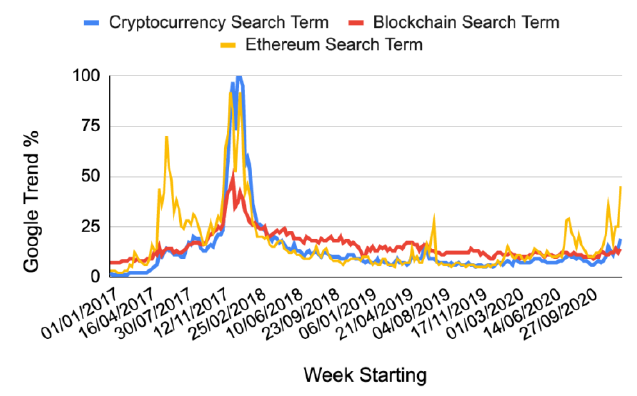
Figure 12: Google search term trend results for ‘Cryptocurrency’, ‘Blockchain’ and